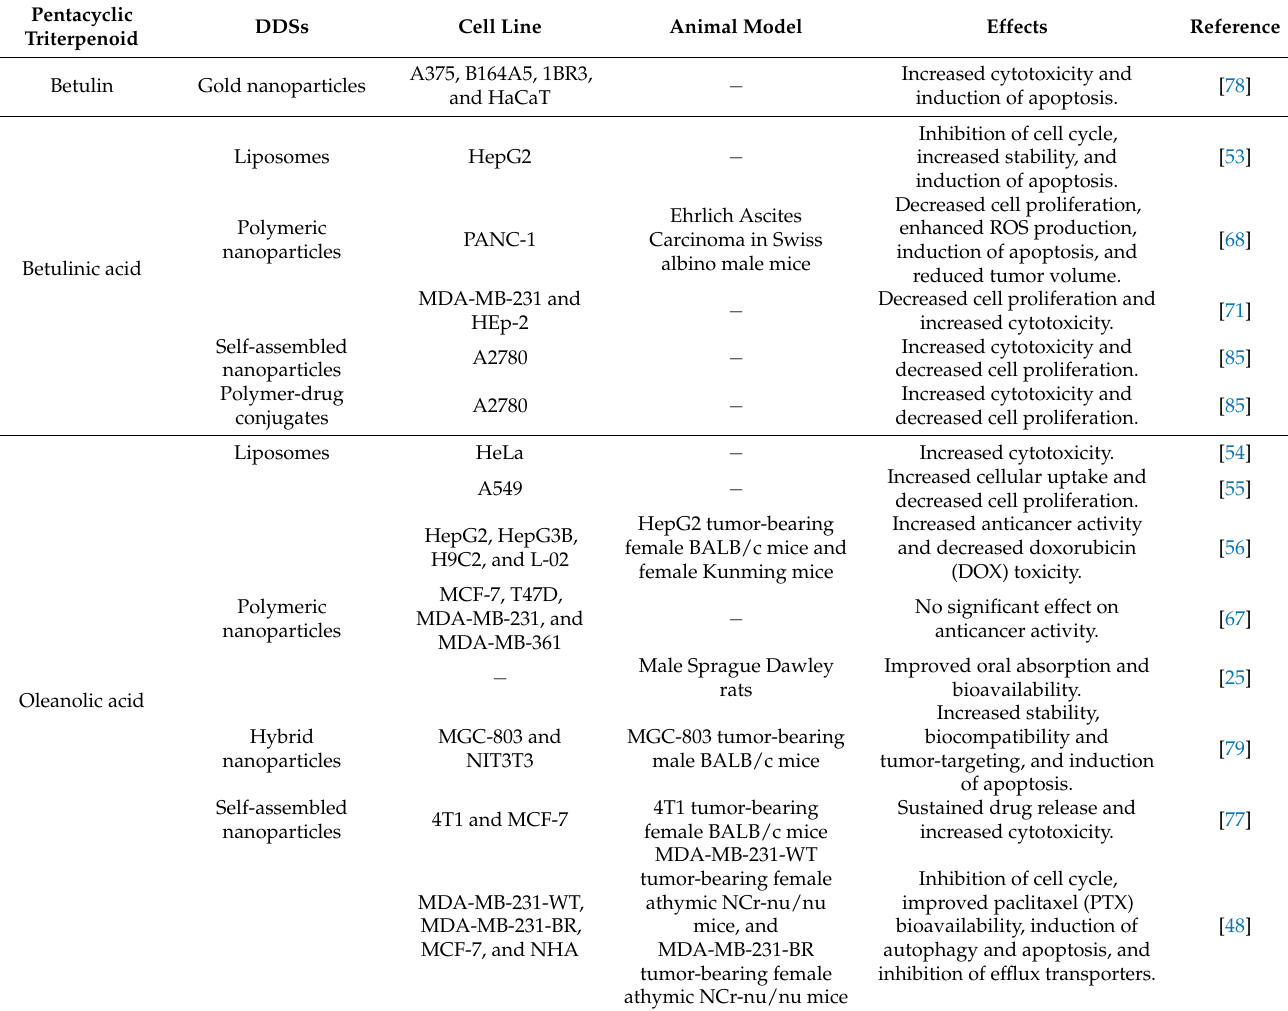
Table 1. The most important information about nanoformulations with pentacyclic triterpenoids. Pentacyclic